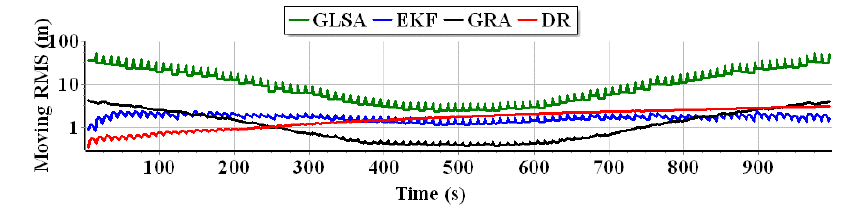
Figure 12. Moving RMS of distance to reference position from the estimated position during 100 SV crossings as a function of time.